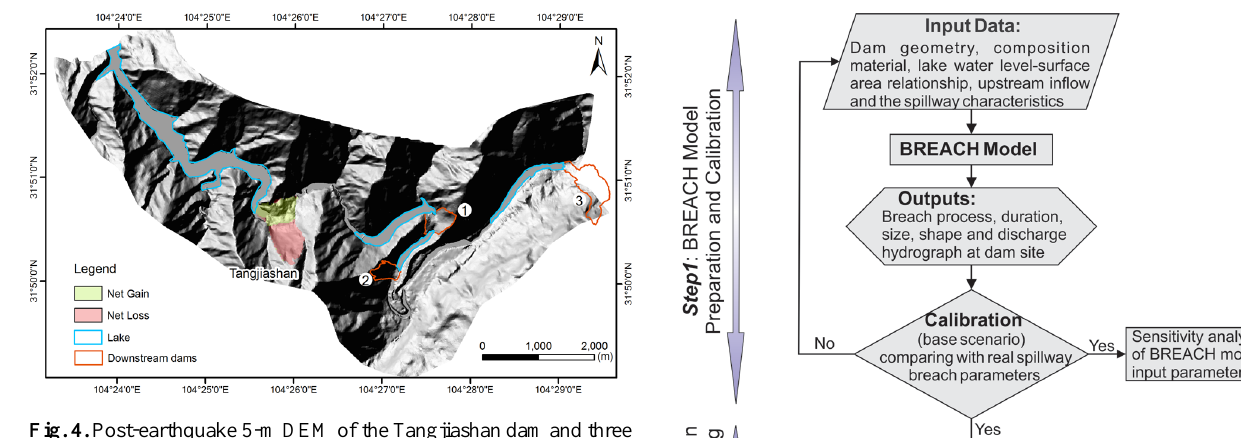
Fig. 4. Post-earthquake 5-m DEM of the Tangjiashan dam and three of the four downstream dams (the fourth one is at the further down- stream).